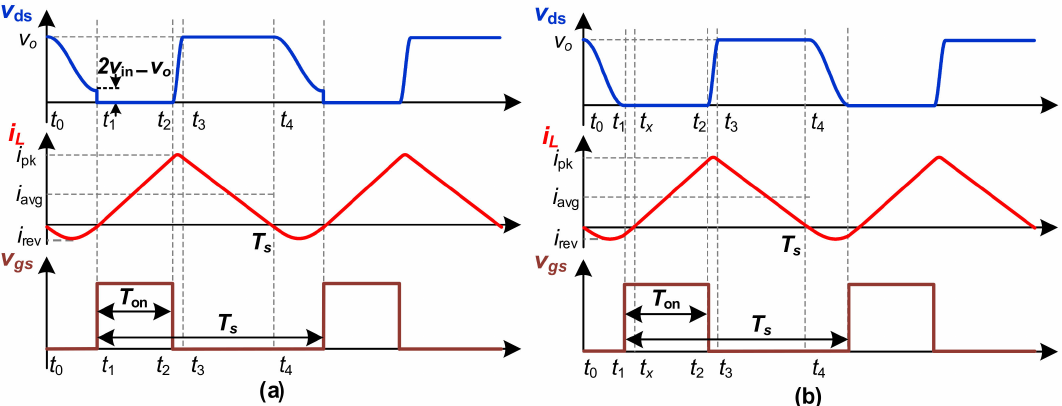
Figure 2. Key waveforms of CRM operations: ( a ) the vs. condition (2 v in > v o ); ( b ) the ZVS condition (2 v in < v o ).